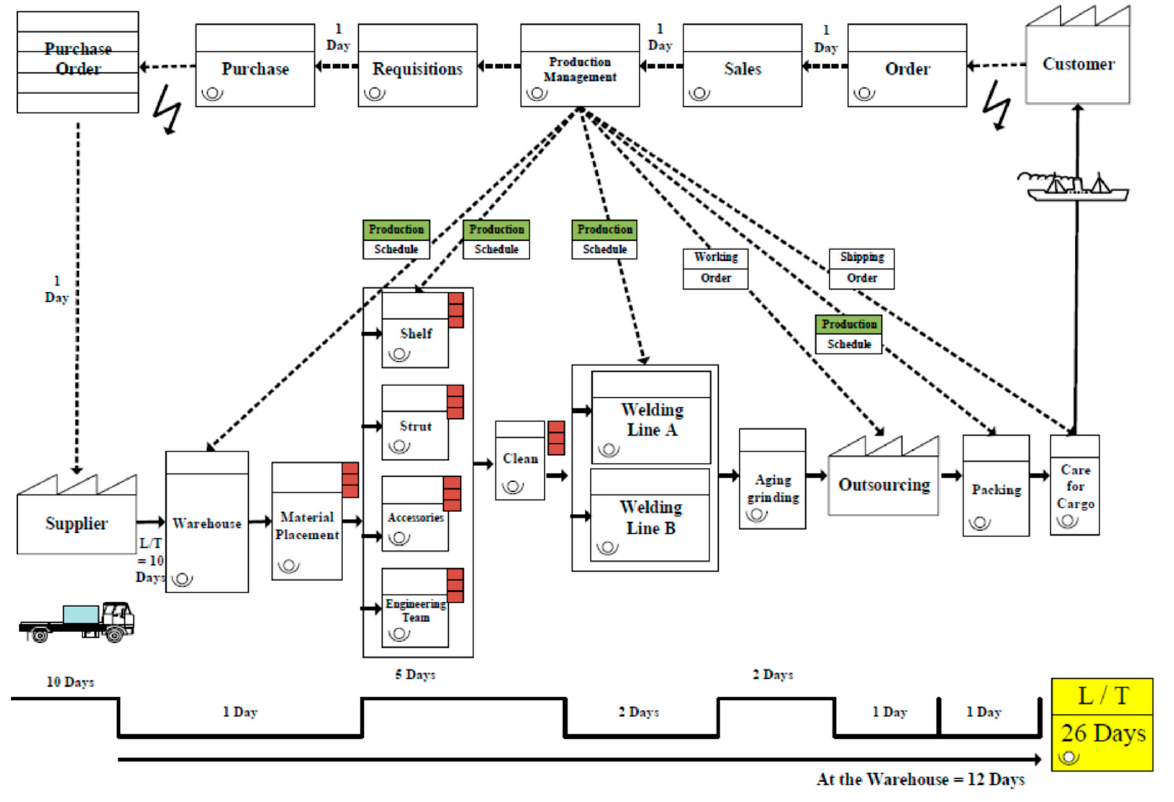
Figure 2. Current VSM.